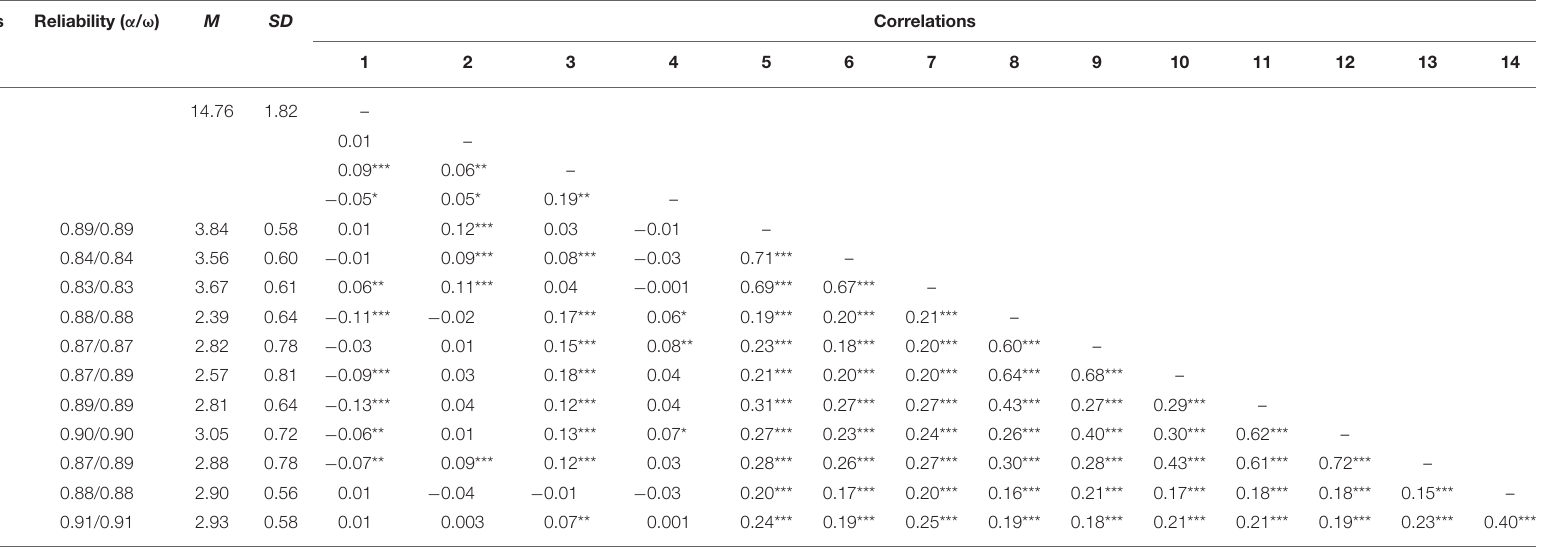
TABLE 1 | Reliabilities, descriptions, and correlations among variables in Study 1 (student